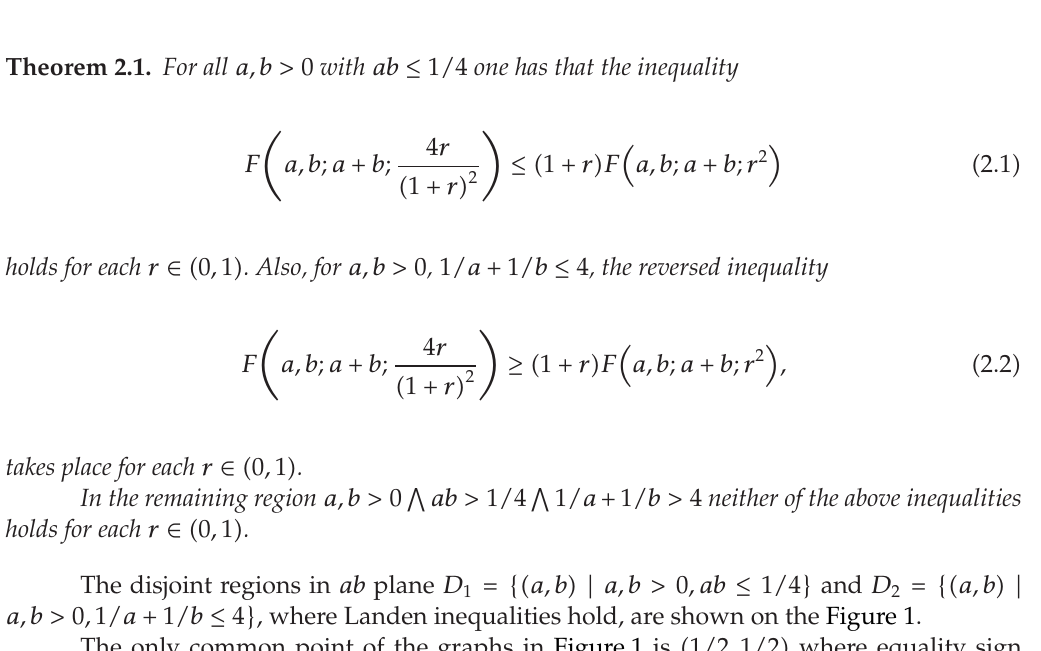
Figure 1: The domains D j , j (cid:5) 1 , 2 , 3